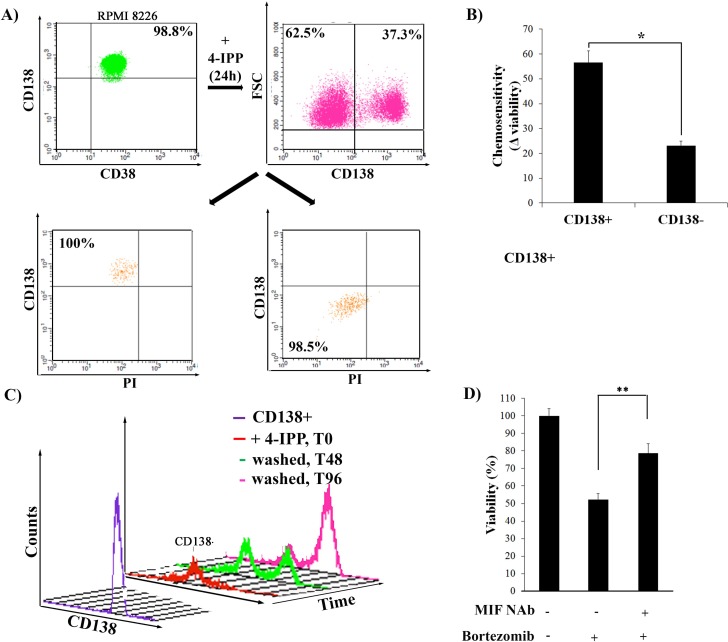
4-IPP dedifferentiated RPMI 8226 CD138- cells are chemoresistant.A) Sorted CD138+ cells were treated with 60μM 4-IPP for 24 h. Cells were stained for CD138 and PI and sorted to recover viable (PI negative) CD138+ and CD138- cells. B) These sorted cells were plated and treated with Bortezomib for 24 h and chemosensitivity was measured as the difference in viability before and after treatment by trypan blue exclusion. *p<0.01 C) Sorted CD138+ cells were treated with 60μM 4-IPP for 24 h. 4-IPP was then washed out and cells were re-plated, harvested at different timepoints, and analyzed for CD138 expression. Purple line is CD138 content at time of plating, demonstrating purity of the initially plated population. Red line is CD138 content in cells treated with 4-IPP for 24 h. CD138 expression measured at 48 (green) and 96 h (pink) post 4-IPP wash out. D) Sorted CD138+ cells were plated and untreated (lane 1), treated with Bortezomib. (lane 2), or treated + MIF Nab and Bortezomib for 24 h (lane 3). The MTT assay used to assess viability of the different populations, mean absorbance values of untreated cells (lane 1) was set to 100 (N = 3). **p<0.001 t-test with Satterthwaite corrections to allow for possible unequal variances. Error bars, mean ± SD.